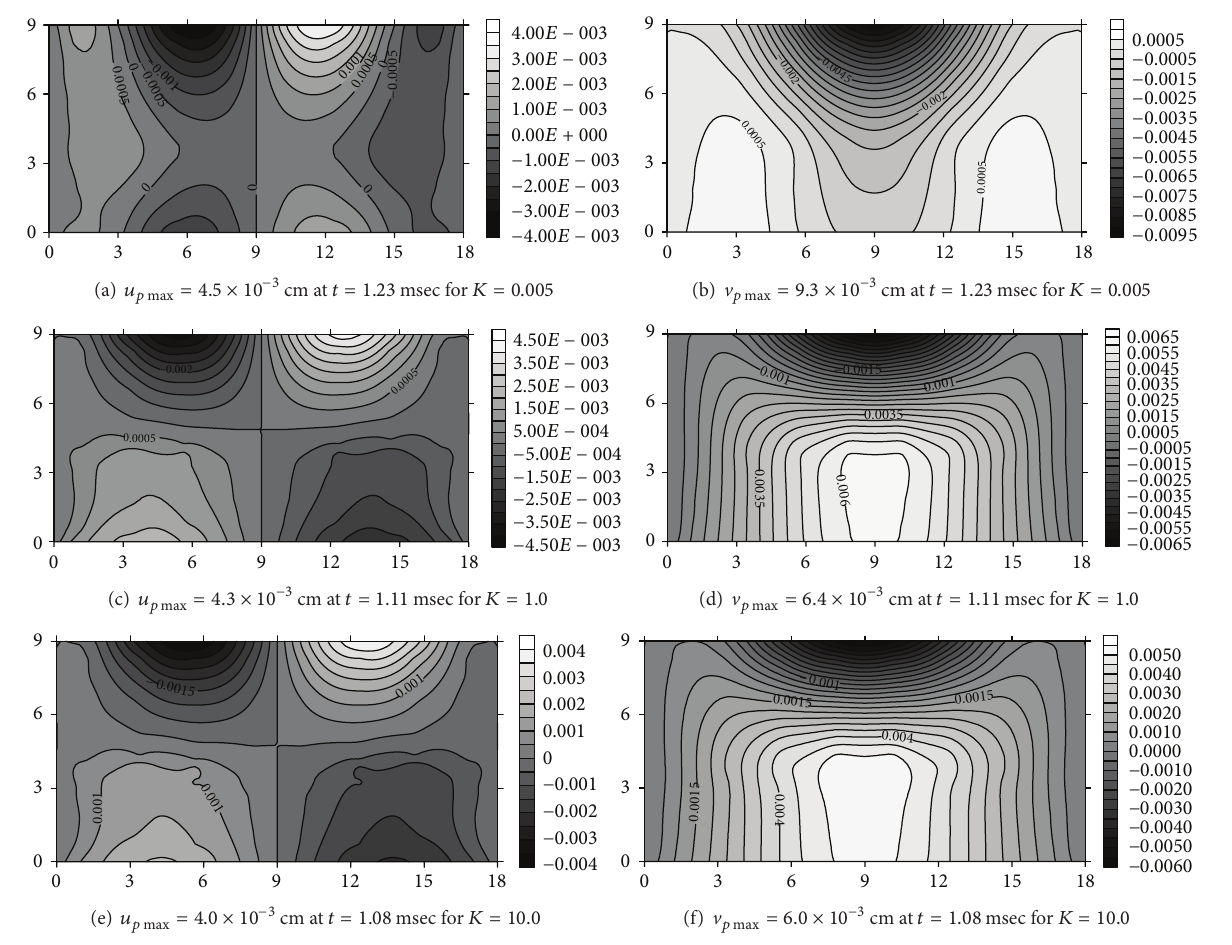
Figure 9: Contour lines of 𝑢 𝑝 , V 𝑝 of the stiffened plate of Example 1 at the time of maximum transverse deflection 𝑤 𝑝 taking into account geometrical nonlinearities.